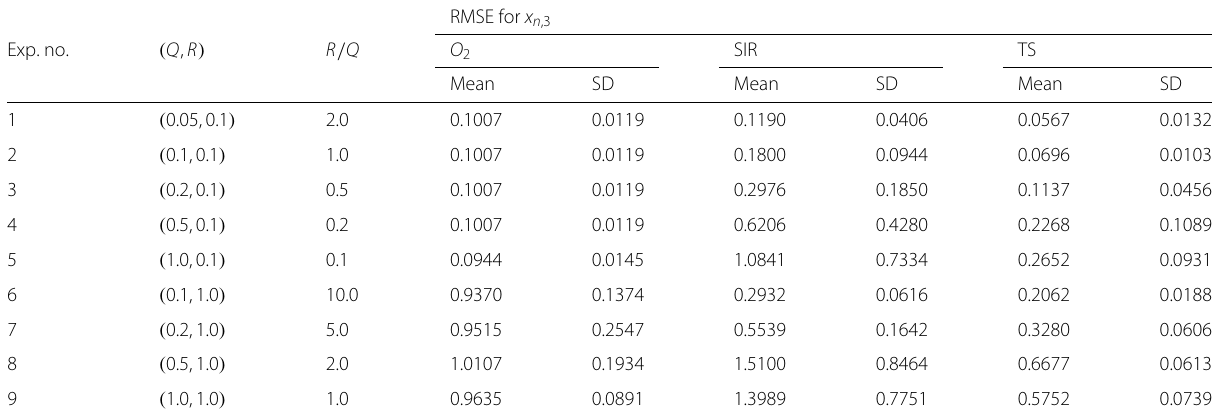
Table 9 Simulation results for Example 2: Mean and standard deviations of the RMSE for three different estimators of x n ,3 , namely, O 2 , the posterior mean based on SIR and the posterior mean based on TS Exp. no.